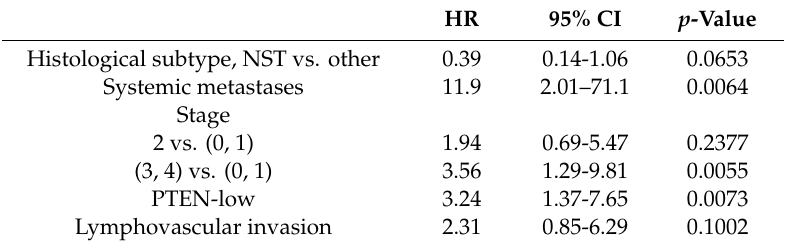
Table 4. Clinicopathologic factors associated with tumor progression in Luminal B breast cancers. Model defined using a stepwise selection of the predictors; significance levels for entry (SLE = 0.25) and for stay (SLS = 0.20). NST, invasive carcinoma of no special type (ductal); HR, hazard ratio; CI, confidence